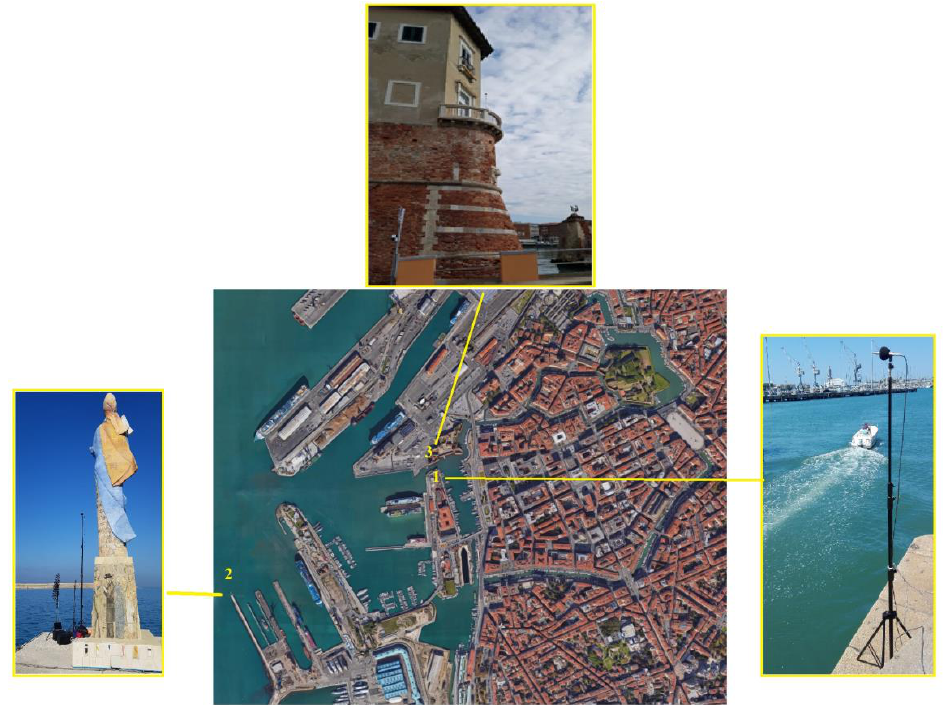
Figure 1. Satellite map of the area and localization of the measurement positions.